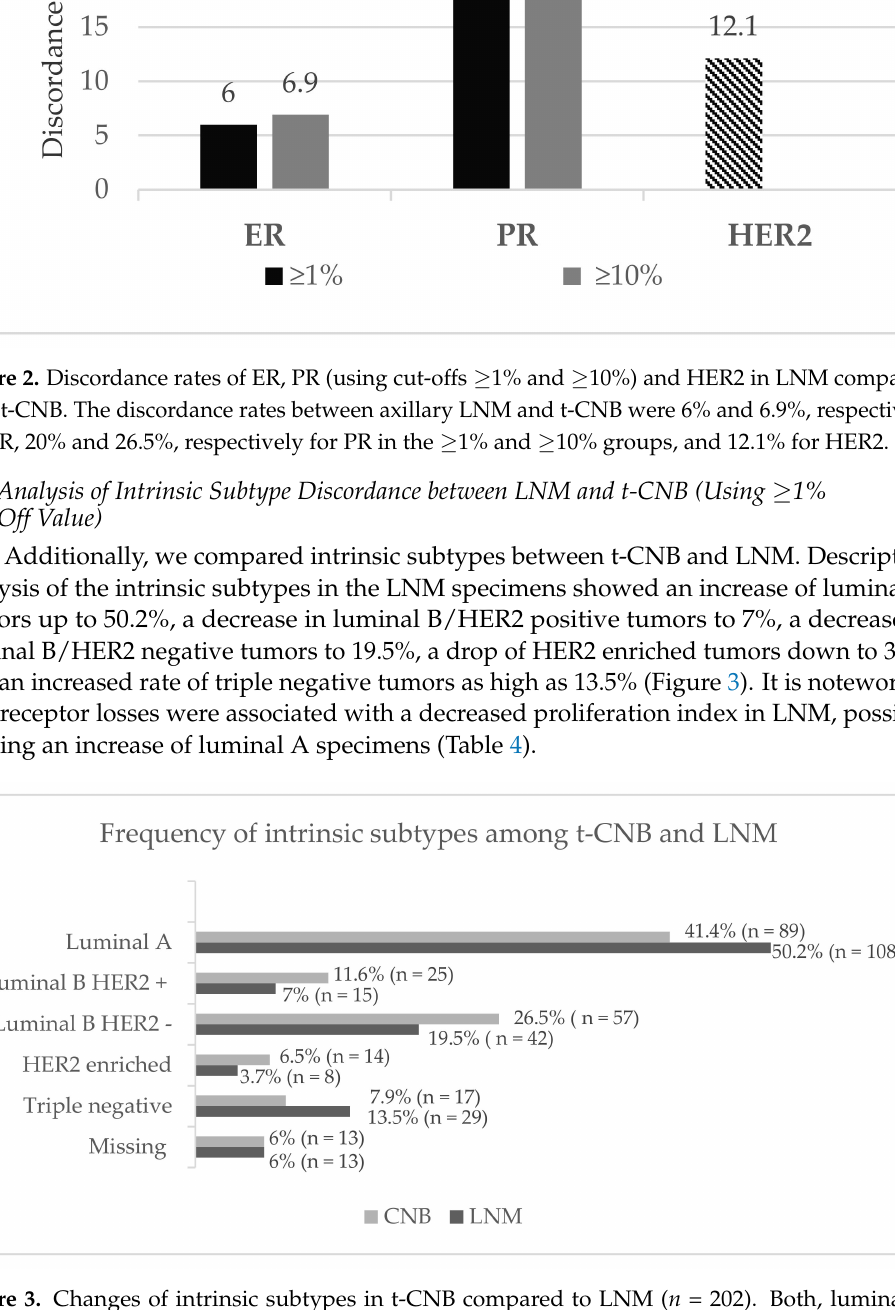
Figure 3. Changes of intrinsic subtypes in t-CNB compared to LNM ( n = 202). Both, luminal A tumors and triple negative tumors, increased by 8.8% and 5.9%, respectively. The rate of luminal B and HER2 enriched tumors decreased between t-CNB and LNM